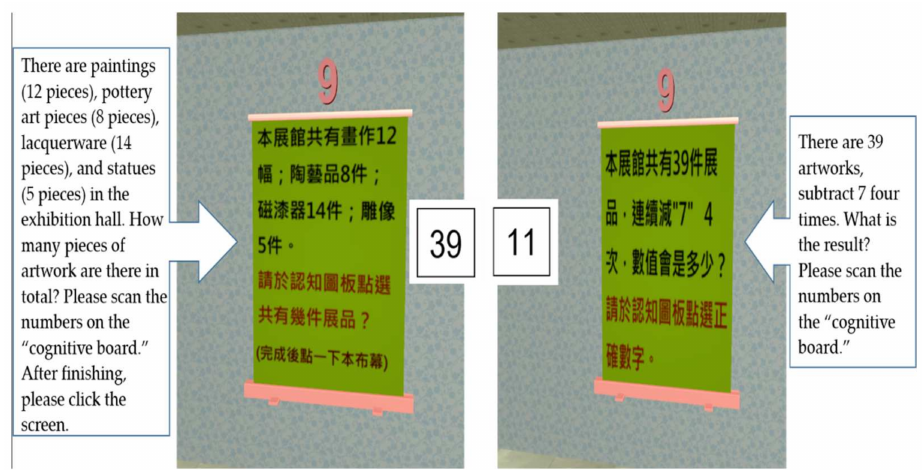
Figure 10. Calculation test screen: ( a ) Instructions screen for adding numbers: there are paintings (12 pieces), pottery art pieces (8 pieces), lacquerware (14 pieces), and statues (5 pieces) in the exhibition hall. How many pieces of artwork are there in total? ( b ) Instructions screen for number subtraction: there are 39 artworks, subtract 7 four times. What is the result?